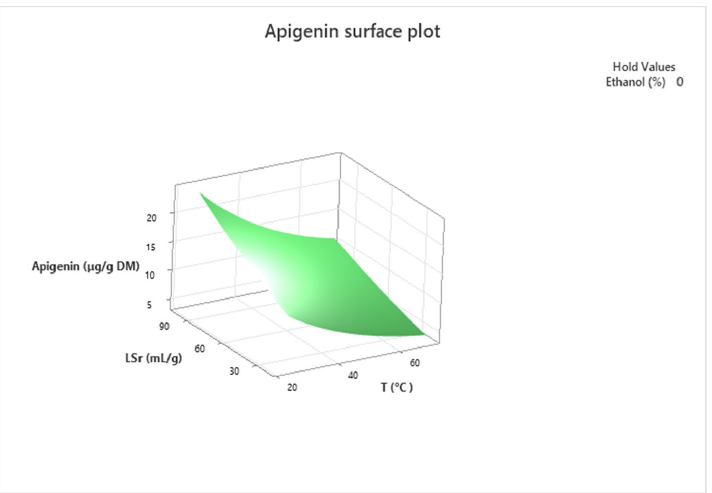
Figure 4. 3D response surface plot of the apigenin (response variable) in μ g/g of dry matter (DM) of parsley as a function of Temperature (X 1 ) in Celsius degrees ( ◦ C) and ratio of solvent to dry parsley (LSr) in ml/g while holding ethanol at 0% ( v / v ).